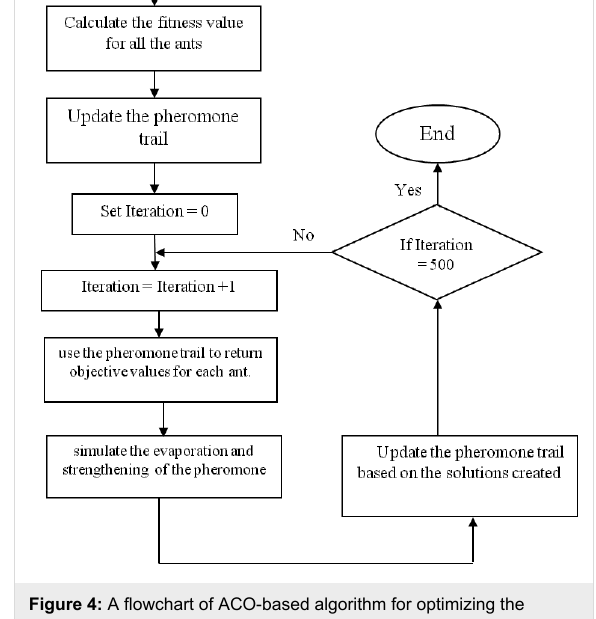
Figure 4: A flowchart of ACO-based algorithm for optimizing the quantum capacitance model.